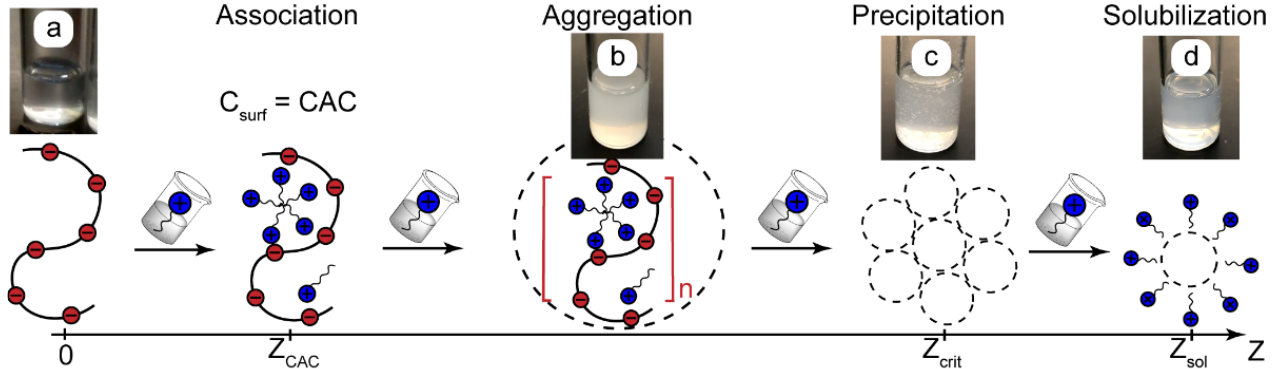
Figure 1. A possible scenario of complexation and phase behavior in solutions of oppositely charged polymers and surfactants depending on the surfactant-to-polymer ratio Z: ( a )—polymer solutions, ( b )—aggregation, ( c )—precipitation, ( d )—solubilization of insoluble aggregates. CAC is the critical association concentration. Z crit is the value of Z corresponding to precipitation. Red dots are poly- electrolyte binding centers, blue dots are surfactant head groups, and n is the degree of aggregation. The photos are PAA (Z = 0) and PAA ‐ CTAB solutions.